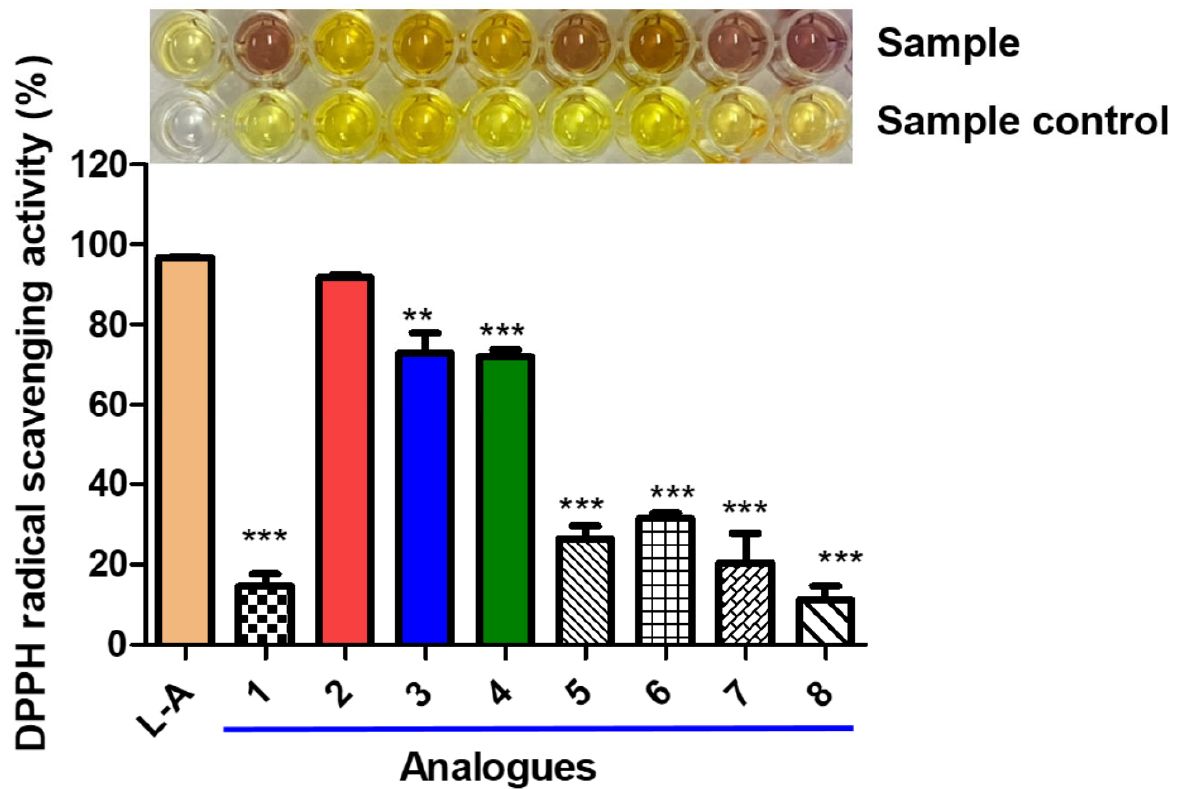
Figure 8. Effects of analogs 1 – 8 on DPPH radical scavenging activity. L -Ascorbic acid (L-A) was used as the positive control. DPPH radical scavenging activities were determined at a test sample (analogs 1 – 8 and L -ascorbic acid) concentration of 500 µ M by measuring the optical densities of sample/DPPH methanol solution mixtures left in the dark for 30 min at 517 nm. Distilled water and dimethyl sulfoxide were used as solvents for L -ascorbic acid and analogs, respectively. Asterisks indicate significant differences between analogs and L -ascorbic acid. Results are presented as the means ± standard errors of three different experiments. ** p < 0.01, *** p < 0.001 for samples treated with analogs 1 – 8 versus L -ascorbic acid treated samples.